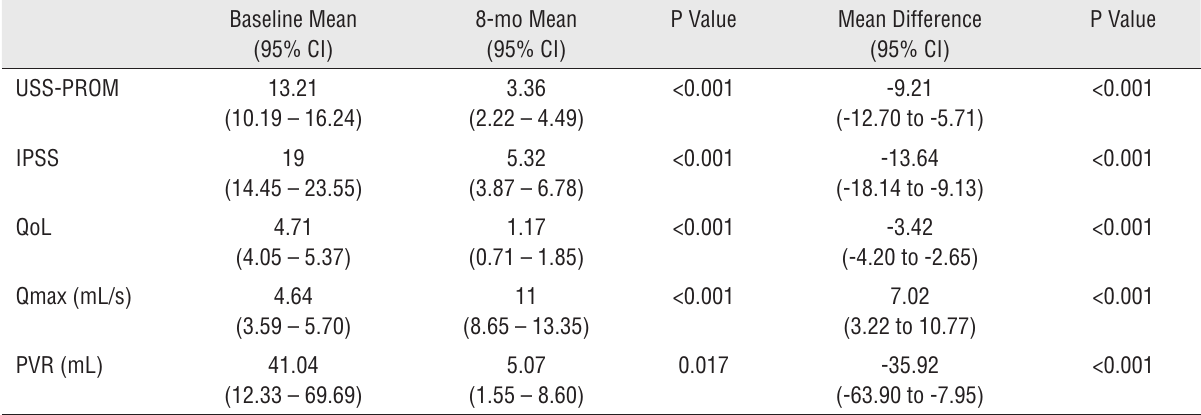
Table 2 – Baseline to 8-month postoperative differences.